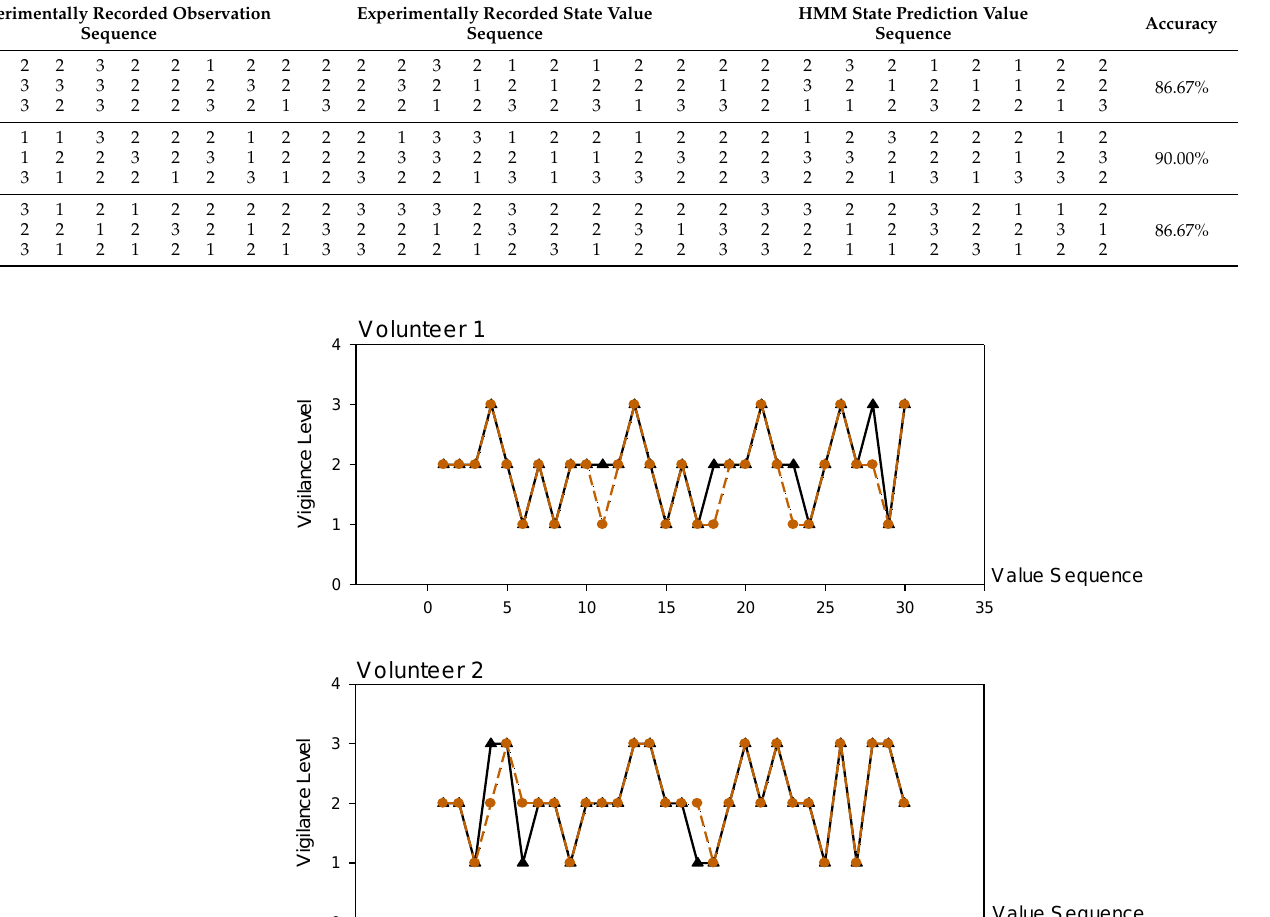
Table 2. Validation results for vigilance assessment using hidden Markov model.